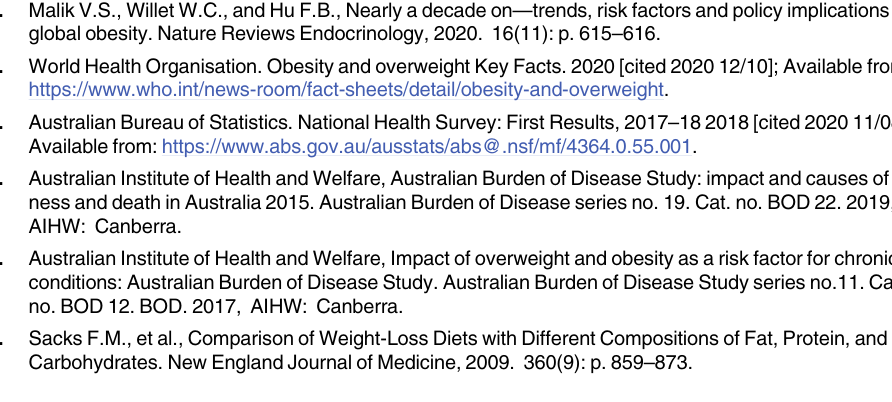
S1 Table. Database for the estimation of the avocado content of Australian foods (AUS- NUT 2011–13